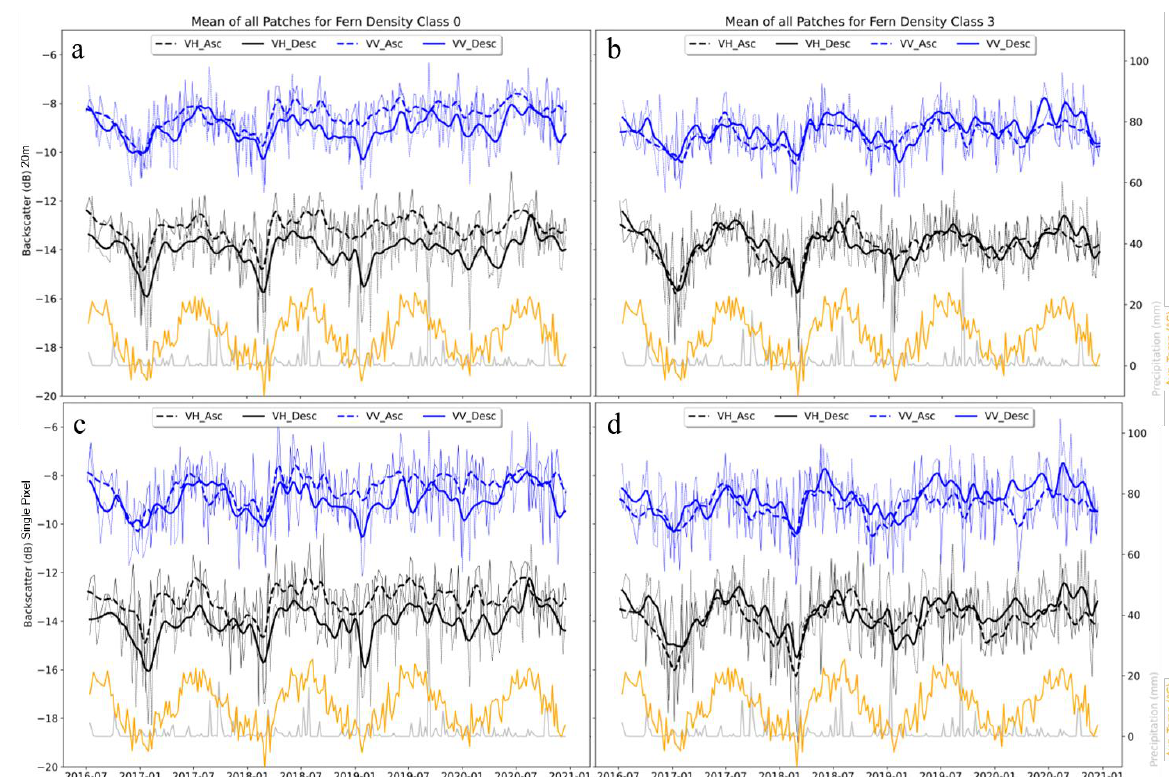
Figure 5: Spatially averaged backscatter time series of the Sentinel-1 C-band signal for the pine forest with no fern present (fern density 0) (a) and pine forest with strong fern undergrowth vegetation (fern density 3) (b) of the 20m patches (top). Single pixel equivalent of the same locations below (c, d). Gray and yellow lines represent daily sum of precipitation and daily average of air temperature from a meteo-station nearby.